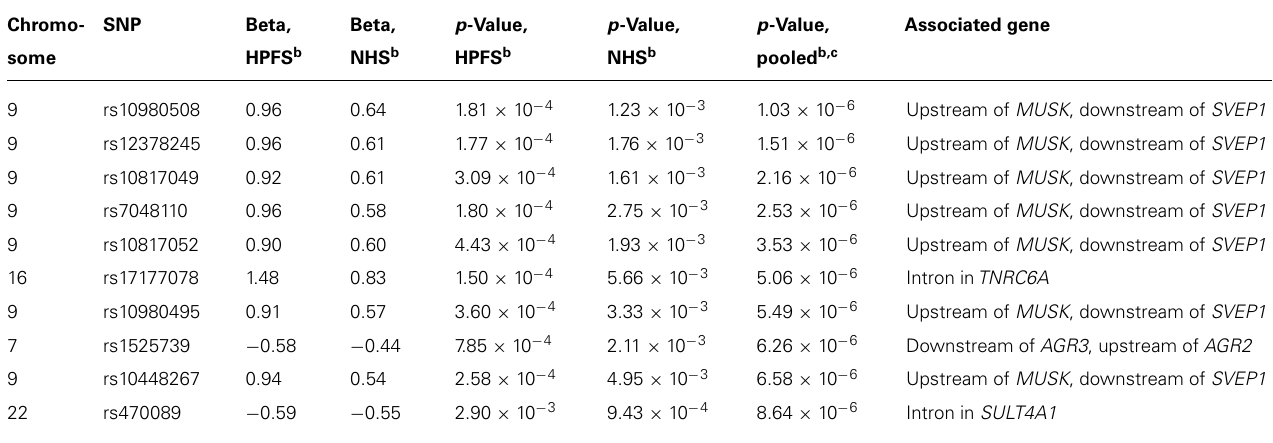
Table 3 |Top 10 p -values from genome-wide SNP–heme interactions predicting type 2 diabetes adjusting for age, body mass index, dietary heme iron intake, and eigenvectors using a one degree of freedom test from meta-analysis of the Health Professionals Follow-up Study and Nurses’ Health Study.